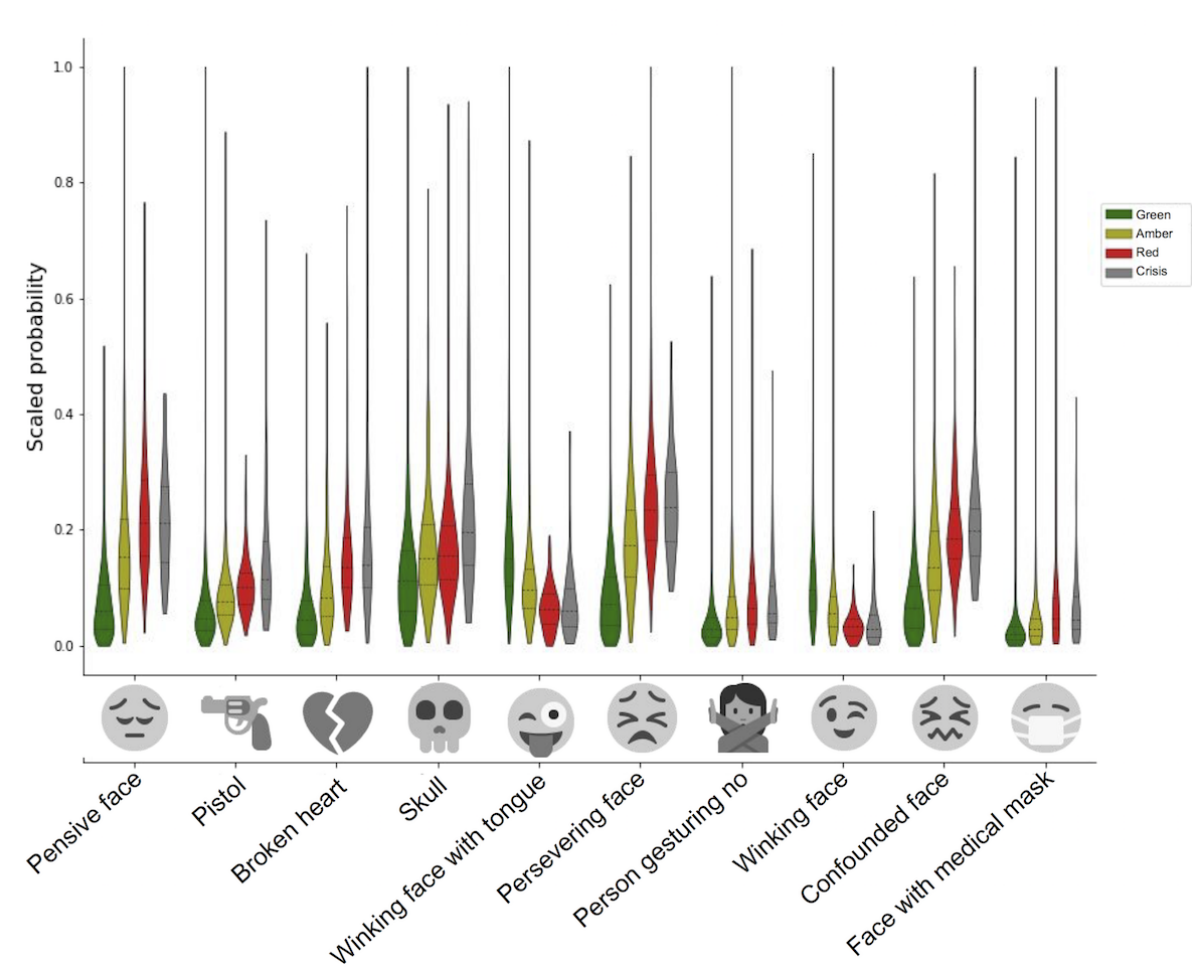
Figure 3. Violin plot showing the distributions of the 10 most discriminative emoji features across labeled classes. The classes are according to label with crisis in gray. The y-axis is the predicted scores for each emoji that have been scaled to the 0-1 interval. The emojis across the y-axis are marked with their images and their official Unicode text labels. The emojis are ranked from the most to least important feature (left to